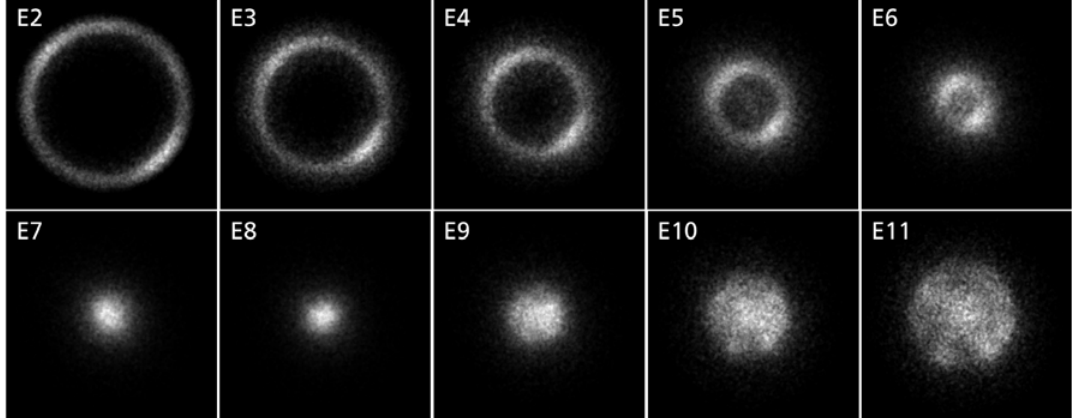
Reprinted with permission from Ref [1]. Copyright 2020, Fraunhofer Verlag. 𝑚𝑚̇ 𝑝𝑝